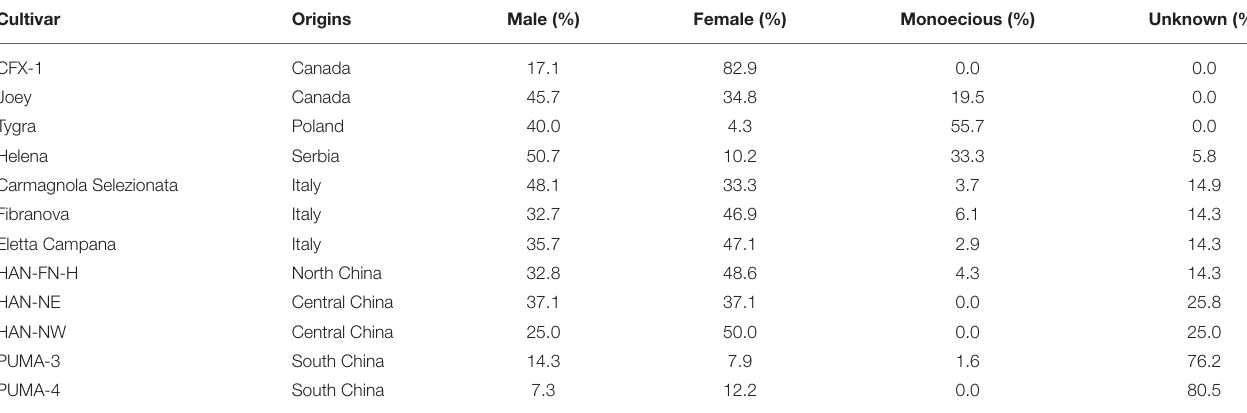
TABLE 2 | Origin and sex status of fiber/grain hemp cultivars in Expt. 2.